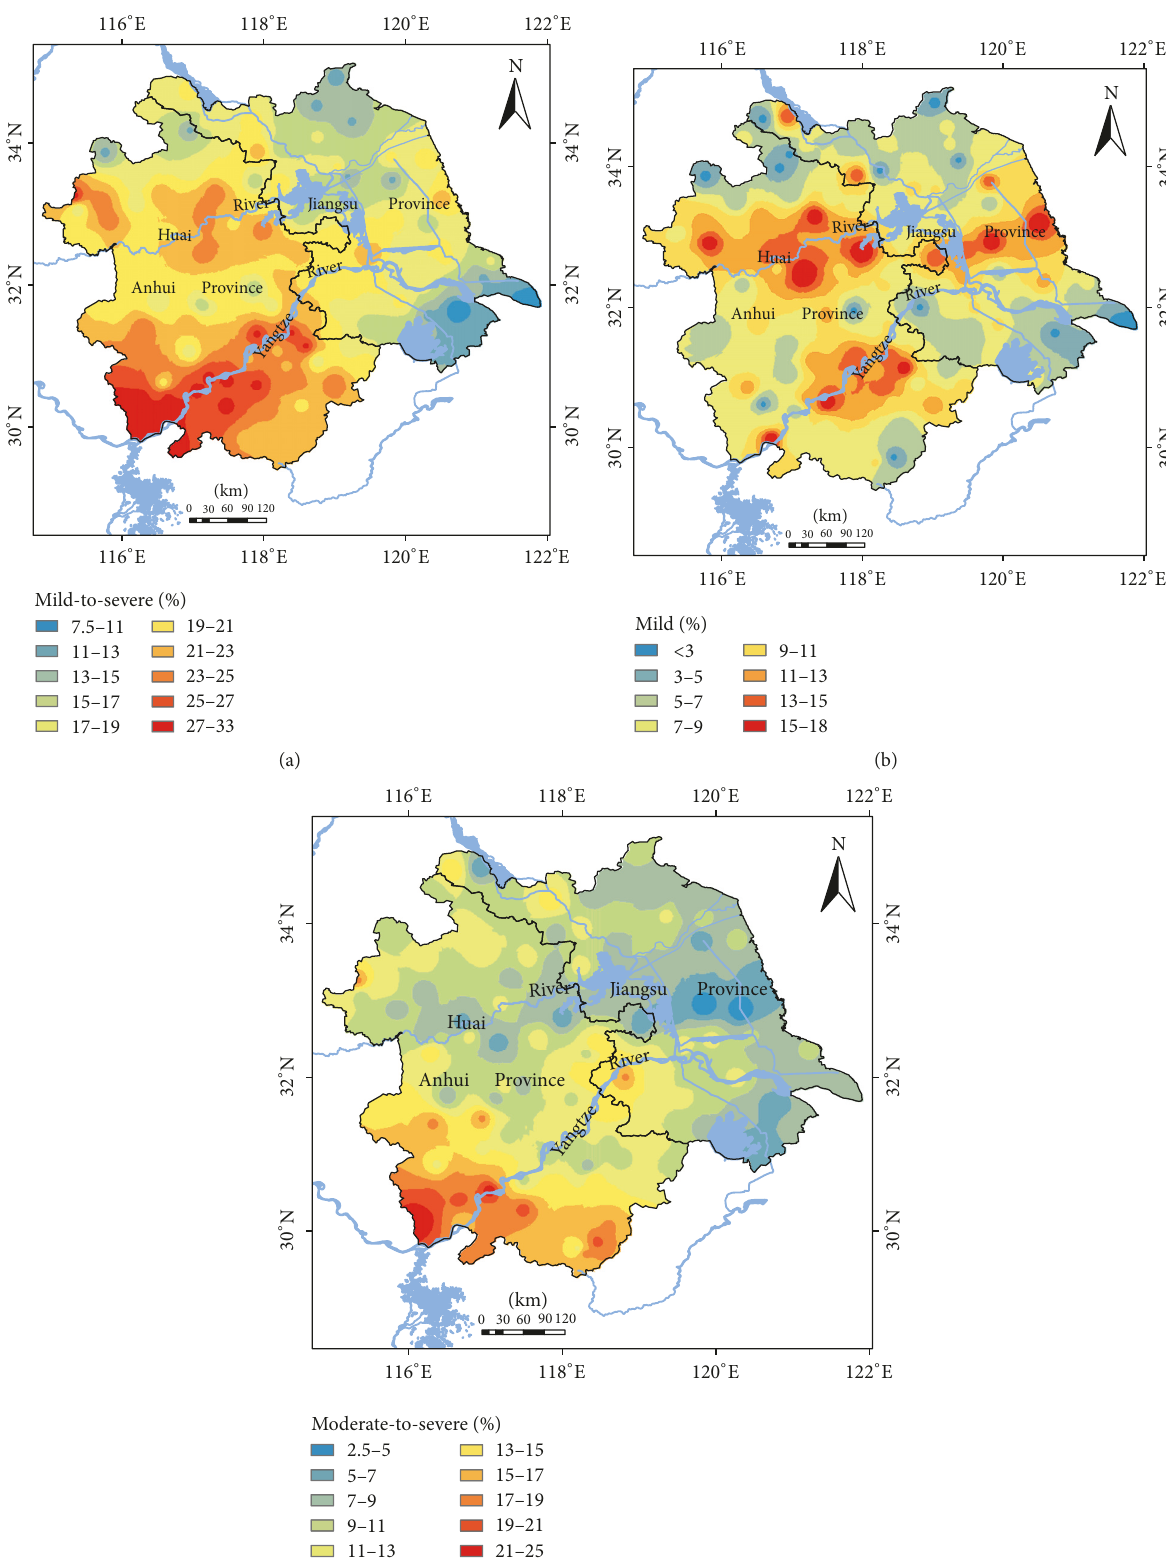
Figure 6: Spatial distribution of the winter wheat waterlogging frequency (in percent) estimated by the WPI in spring. (a) Mild-to-severe, (b) mild, and (c) moderate-to-severe waterlogging of winter